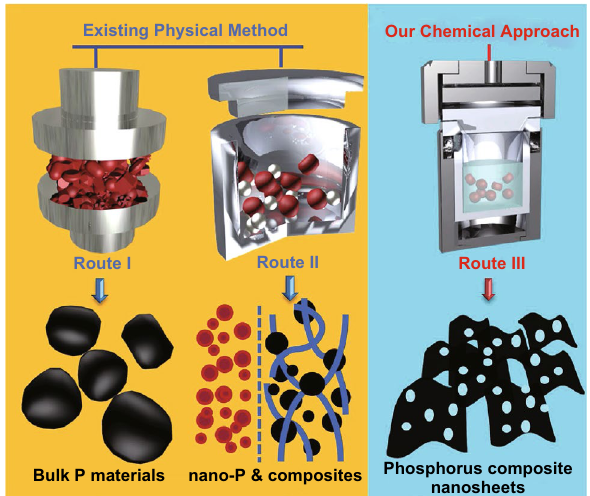
Fig. 5 Schematic illustration of the formation of phosphorus-based materials. a Existing physical solid-state methods: Route (I) for the formation of bulk black P materials by traditional high-pressure method. Route (II) for the formation of nanosized (left) P material or its nanocomposites (right; carbon-, metal-composite, etc.) via normal/ high energy mechanical milling methods. b Our chemical approach: Route (III) for the preparation of holey phosphorus-based composite nanosheets via a chemical solvothermal reaction. Reproduced